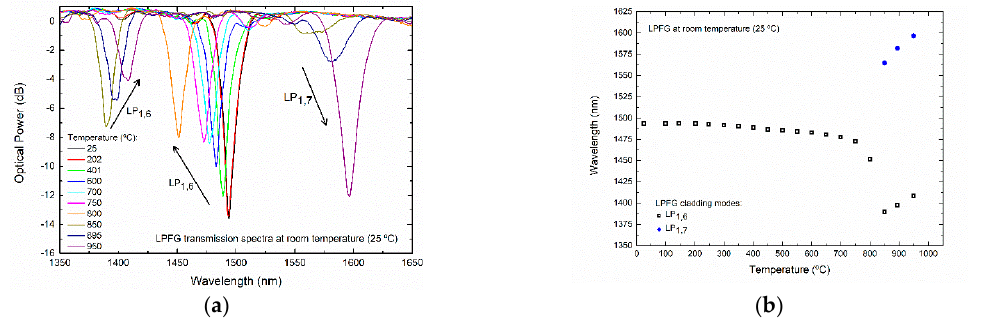
Figure 2. ( a ) Transmission spectra of the LPFG at room temperature (25 °C) after annealing at the specified temperature; ( b ) wavelength shift.